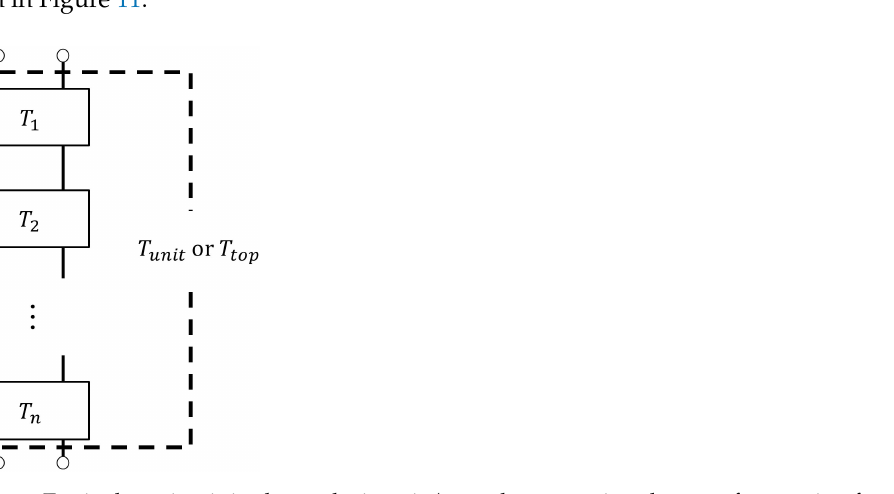
Figure 11. Equivalent circuit in the analysis unit (cascade connecting the transfer matrix of each element).